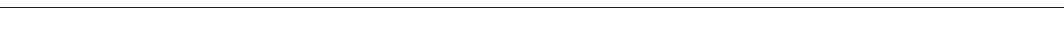
Fig. 5 Low inter-KT stretching barely activates Aurora-B at KTs. a Left panel shows immuno fl uorescence images of hTert-RPE1 GFP-CENPA cells (green) treated with DMSO, 100 μ M monastrol, or 2 μ M Aurora-B inhibitor ZM1, and stained with DAPI (blue) and pSer100-Dsn1 antibodies (red); insets show exemplary sister-KT pairs; right panel shows quanti fi cation of normalized pSer100-Dsn1/GFP-CENPA ratio after background subtraction. *DMSO vs. monastrol p = 0.0265, **DMSO vs. ZM1 p = 0.0023 in ratio paired two-tailed t-test, error bars represent s.e.m., N = 4, n = 340 – 500 KTs. b Left panel shows immunostaining of pSer100-Dsn1 in hTert-RPE1 GFP-CENPA cells co-treated with 100 μ M monastrol, and DMSO, 12 nM BAL2782 or 2 μ M ZM1; insets show exemplary sister-KT pairs; right panel shows quanti fi cation of normalized pSer100-Dsn1/GFP-CENPA ratio after background subtraction. DMSO vs. BAL27862 p = 0.8442, **DMSO vs. ZM1 p = 0.0046, in ratio paired two-tailed t -test, error bars represent s.e.m., N = 3, n = 600 KTs. c Left panel shows immunostaining of pSer100-Dsn1 (red) in metaphase hTert-RPE1 GFP-CENPA cells treated with DMSO, 12 nM BAL27862, or 2 μ M ZM1; insets show exemplary sister-KT pairs; right panel shows quanti fi cation of normalized pSer100-Dsn1/GFP-CENPA ratio after background subtraction, **DMSO vs. BAL27862 p = 0.0072, **DMSO vs. ZM1 p = 0.0048 in paired two-tailed t -test, error bars represent s.e.m., N = 3, n = 300 – 600 KTs